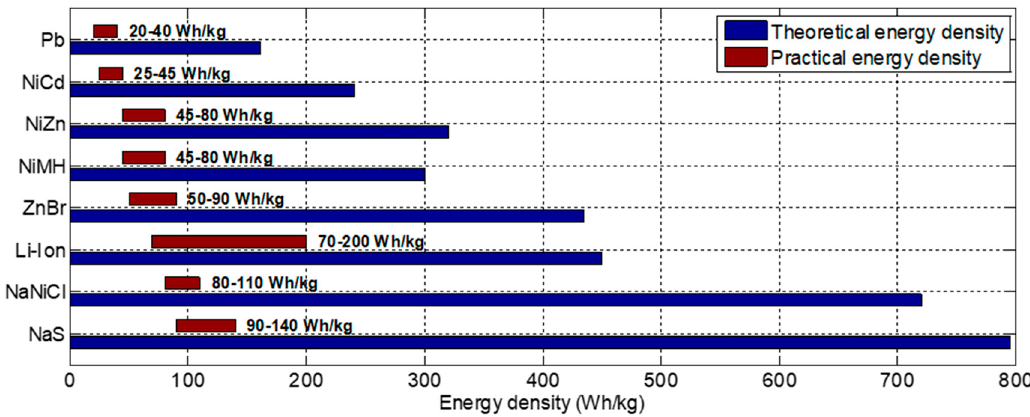
Figure 6. Theoretical and practical energy densities for different battery types (Data from [35,69]).